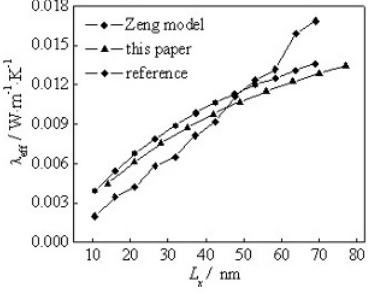
Fig. 2. Verification of numerical simulation